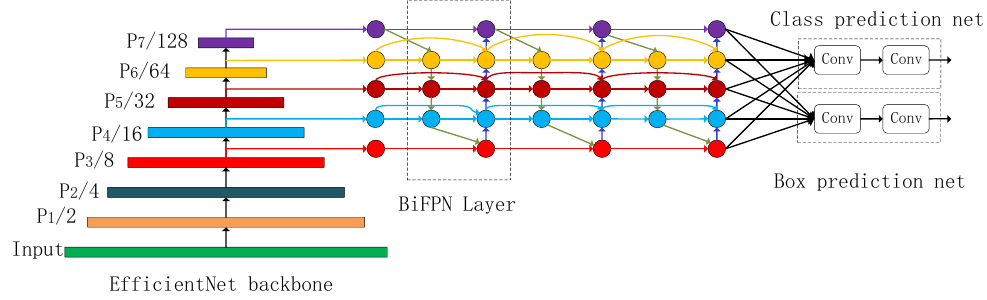
Figure 8. The EfficientDet-D0 structure.